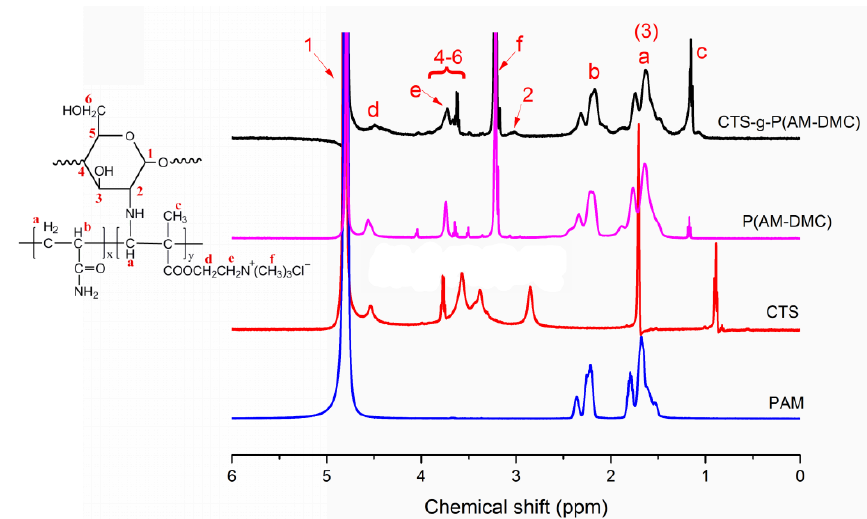
Figure 1. 1 H nuclear magnetic resonance spectroscopy ( 1 H NMR) spectra of PAM, chitosan (CTS), Figure 2. P(AM-DMC), and CTS- g -P(AM-DMC).